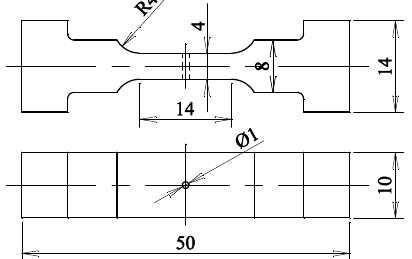
Figure 1: Shape and dimensions of the specimen